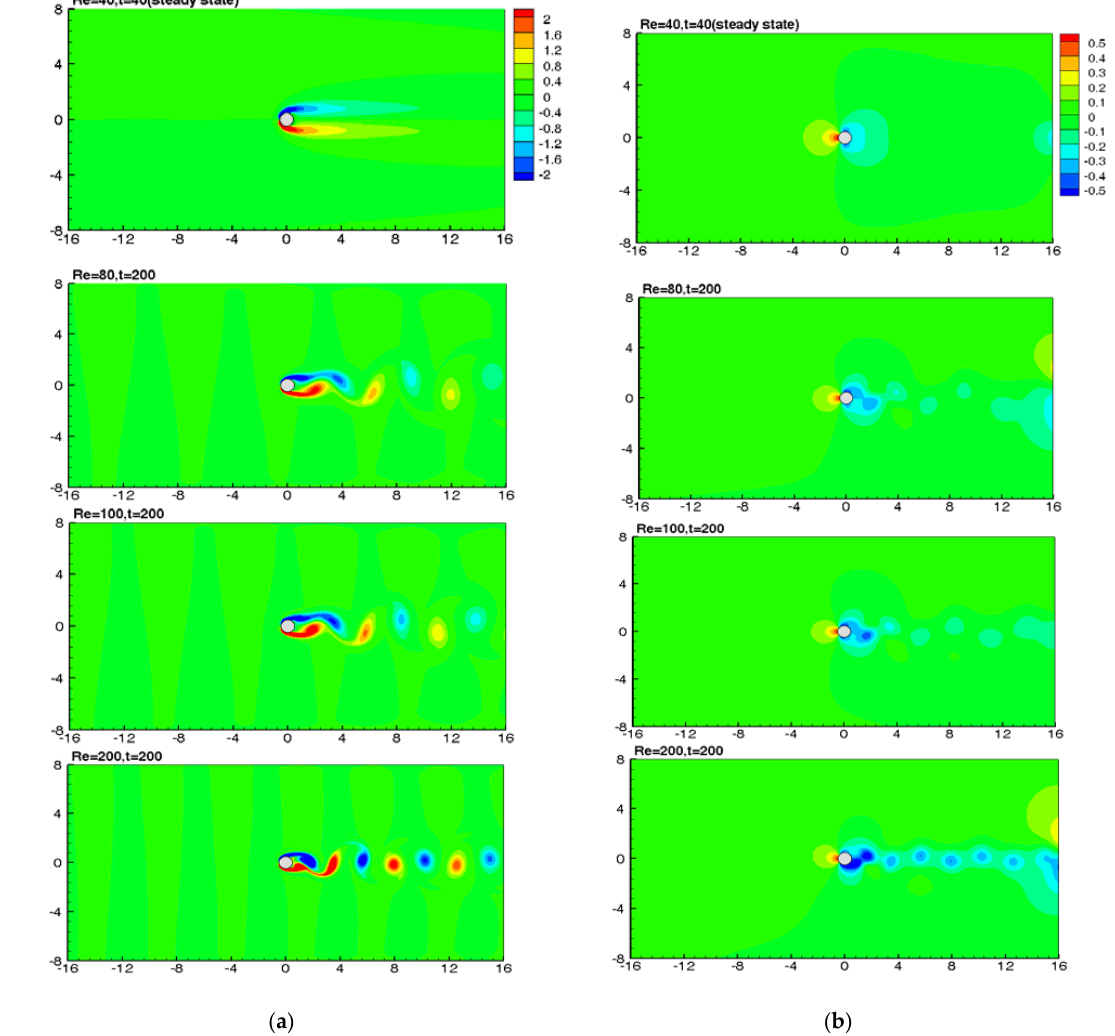
Figure 4. Instantaneous distribution patterns of ( a ) vorticity and ( b ) pressure at t = 200 for a uniform flow past a cylinder at Re = 40, 80, 100, and